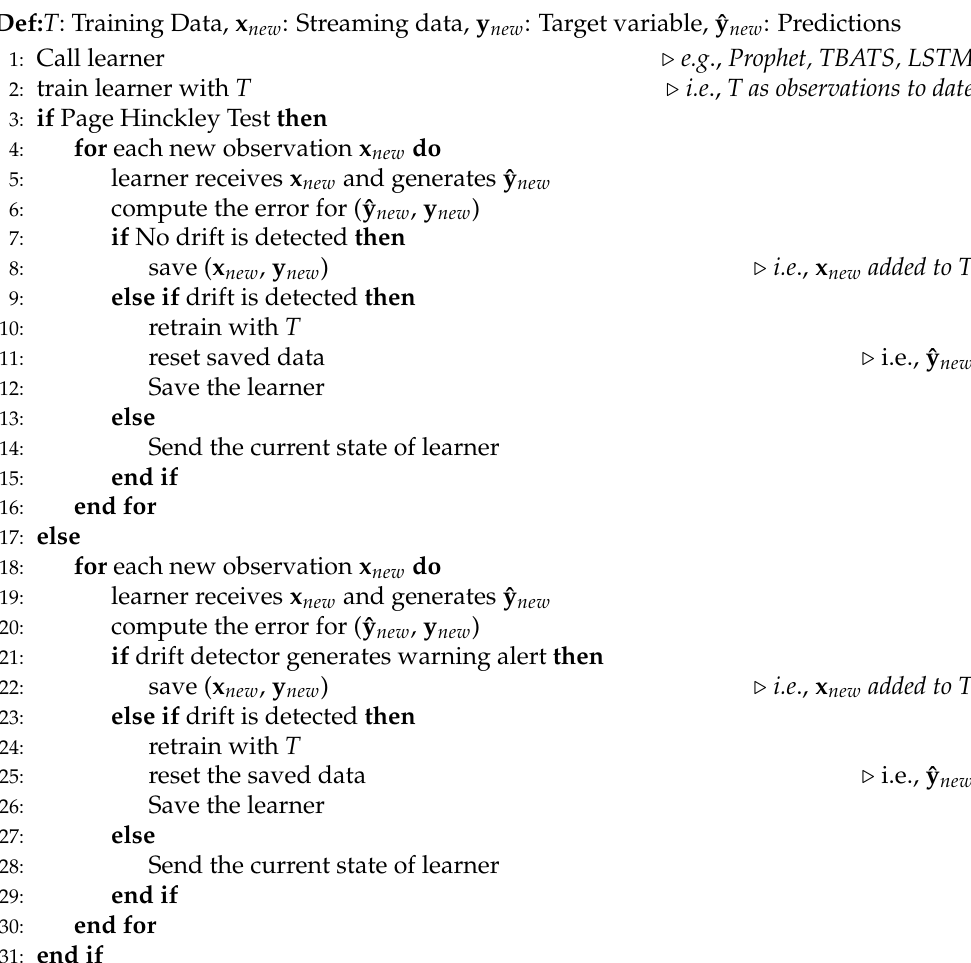
Figure 1. Concept drift adaptation algorithm, modified from